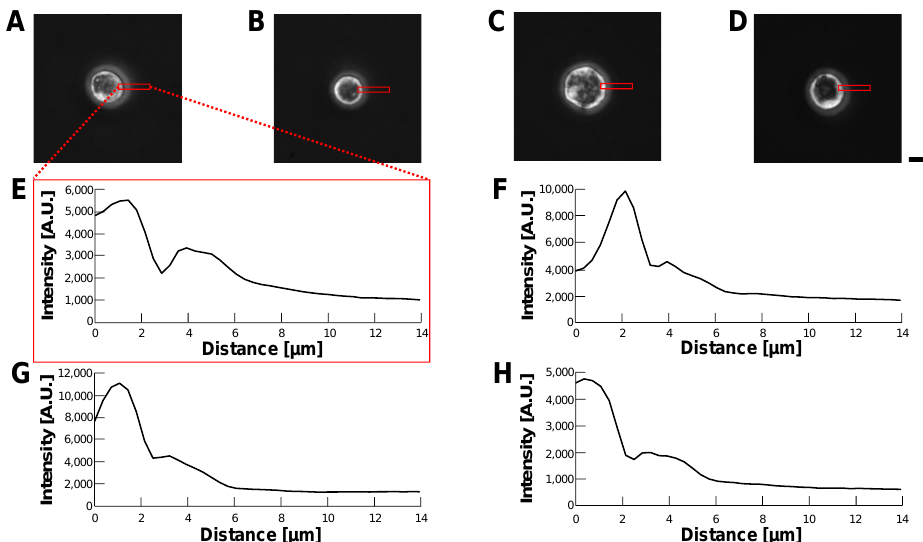
Figure 12. Comparision of permeability of HeLa cell-encapsulated alginate microcapsules in var- ious buffer conditions by phase-contrast observation. ( A – D ): Phase-contrast images of HeLa cell- encapsulated alginate microcapsules. ( A ): 5% glucose solution ( B ): 10% glucose solution ( C ): 15% glucose solution ( D ): 1% alginate ester. ( E – H ): Intensity profiles of HeLa cell-encapsulated alginate microcapsule images ( A – D ), respectively. Bar, 10µm.